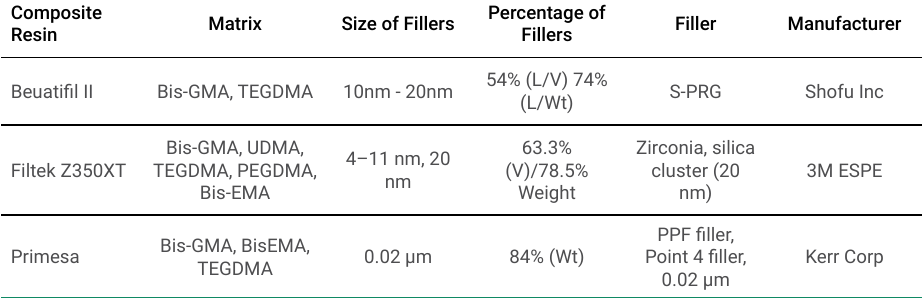
Table 1. Composite resins tested in this